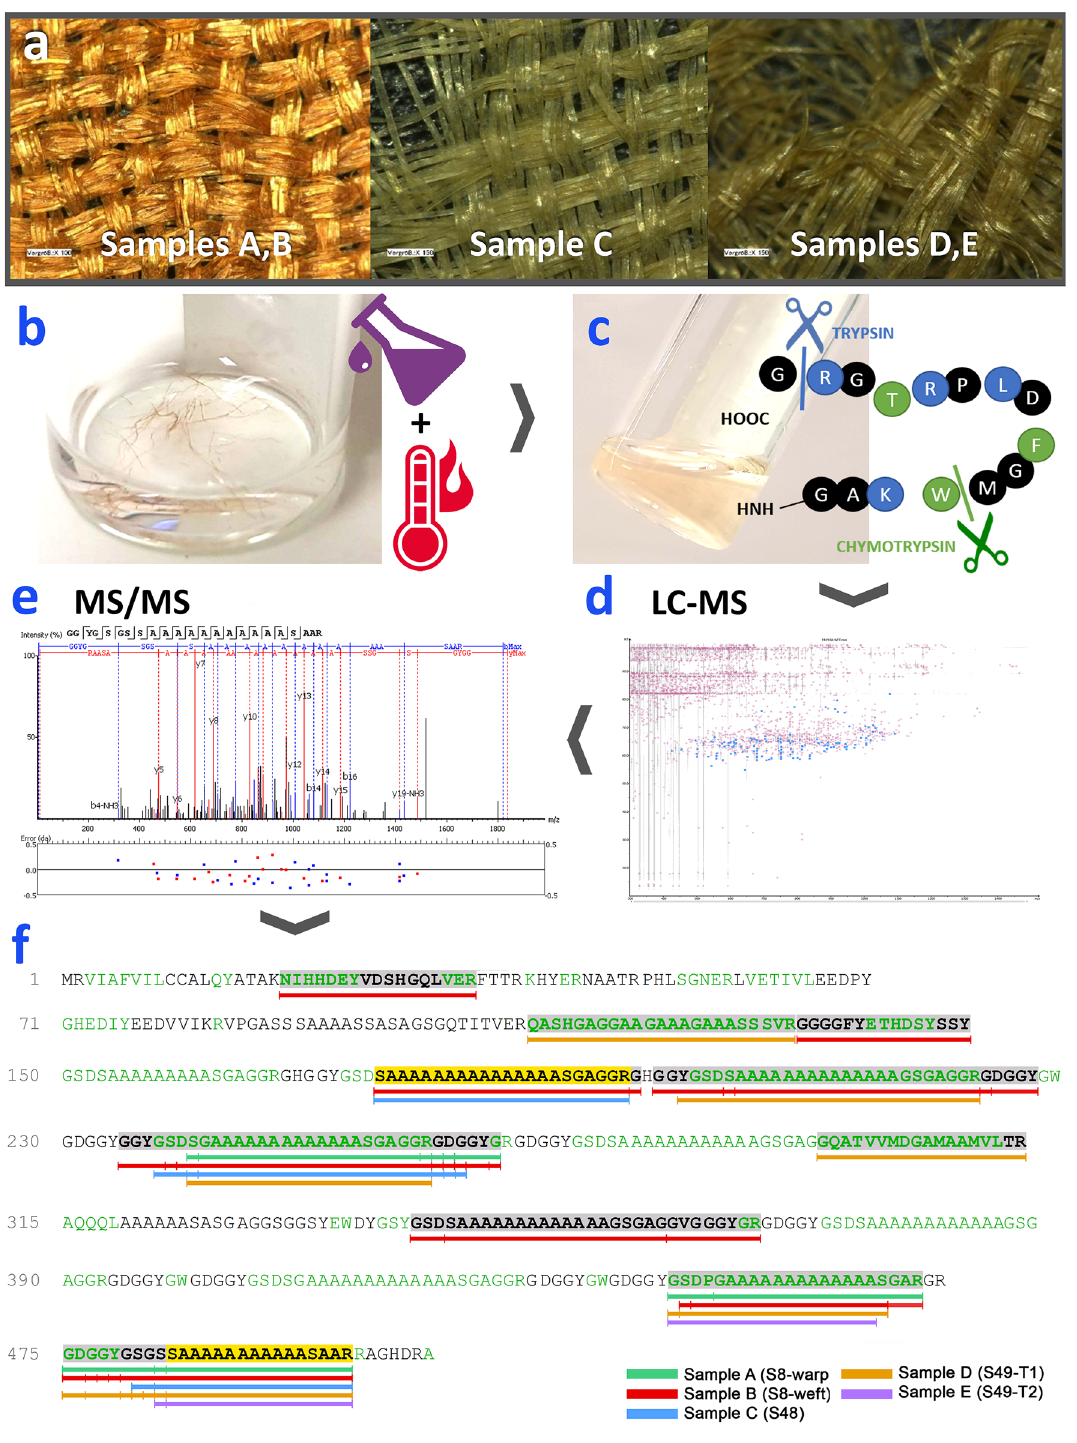
Figure 5. Workflow for sample preparation, sample analysis, data processing and species interpretation of Palmyra silks samples. (a) Sample for analysis– images of the Palmyra textiles: sample S8(left), Schimidt-Colinet/Stauffer Katalog Nr. 305 (magnification × 100); sample S48 (center), Schimidt-Colinet/Stauffer Katalog Nr. 312 (magnification × 150); sample S49(right), Schimidt-Colinet/Stauffer Katalog Nr. 313 (magnification × 150). (b) Fibers from S8 (weft) placed in a 7 M Ca(NO 3 ) 2 solution at 80˚C. (c) Solubilisation of